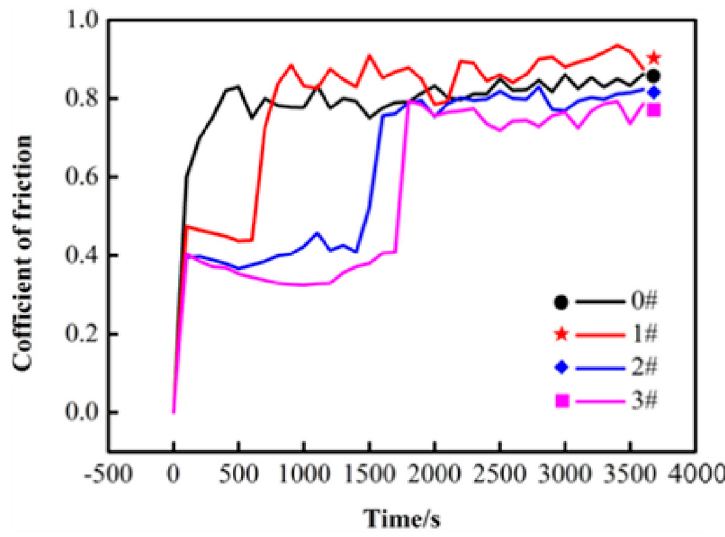
Figure 11. Coefficient of friction under 2 N load.